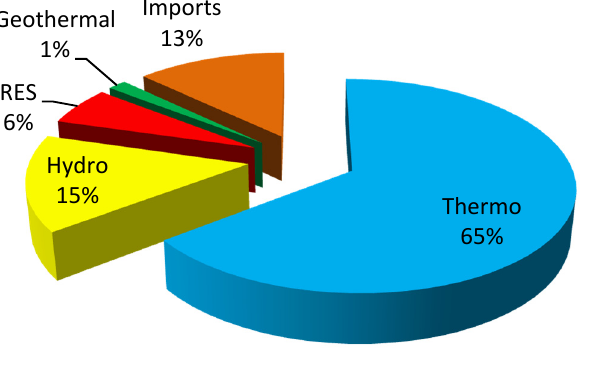
Figure 7. Italian Electricity net production per energy source and imports in 2010